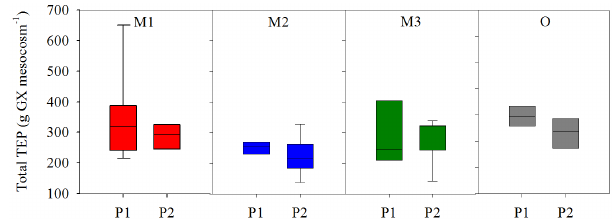
Figure 2. Total content of transparent exopolymeric particles (TEP) per mesocosm and in the lagoon waters surrounding the meso- cosms. The average amount in gGXmesocosm − 1 for the two pe- riods of the experiment after DIP fertilization was calculated from the total daily amount based on concentrations measured at three depths and integrated for the specific volume per mesocosm or for an equivalent volume of lagoon water. Averages are represented in box plots as a function of two different phases: P1 = days 5–14 and P2 = days 15–23. Red, blue, green, and black denote Mesocosm 1 – M1, Mesocosm 2 – M2, Mesocosm 3 – M3, and outside lagoon – O, respectively. Straight lines within the boxes mark the median. No significant differences were observed between the phases or be- tween the three mesocosms and the outside lagoon (Kruskal–Wallis nonparametric analysis of variance; p >